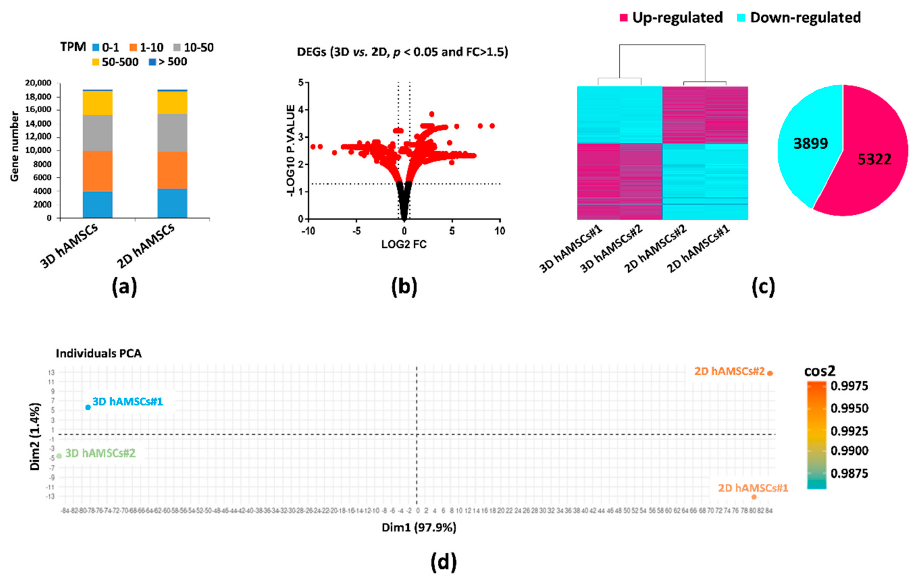
Figure 2. Gene expression profiles and differential expression in human amnion mesenchymal stem cells (hAMSCs) grown as both monolayer (2D) and spheroids (3D). ( a ) Gene expression distribution in both 2D and 3D hAMSCs. ( b ) Volcano plot analysis of differentially expressed genes (DEGs) in 3D vs. 2D hAMSCs ( p < 0.05 and fold change >1.5). ( c ) Expression clusters (z-scores) of both up- and downregulated genes after volcano plot analysis in 2D and 3D hAMSCs. ( d ) Principal component analysis (PCA) of both 2D and 3D hAMSCs. Both KEGG and GO enrichment analysis revealed that, among the top 3000 upregu- lated genes found in 3D hAMSCs, many DEGs were linked to immunomodulation, pro- liferation/differentiation, and angiogenesis. For example, KEGG analysis showed that the only two significant enriched pathways were the “TNF signaling pathway” and the “NF- kappa B signaling pathway” (Figure 3a). Many of the GO terms (ranked by p -value) asso-